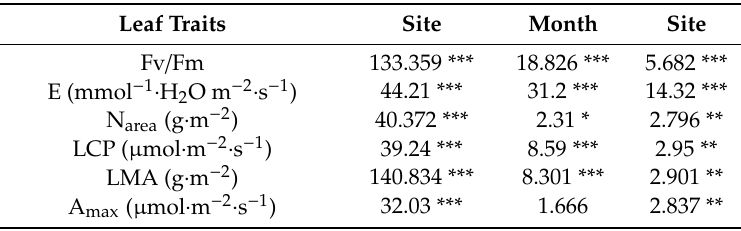
Table 2. The F values of two way-ANOVA for e ff ects of site, month and their interactions on each leaf traits (n = 144) of M. condensatus . Abbreviations are maximum quantum yield of PSII (Fv / Fm); transpiration rate (E); leaf N content (Narea); light compensation point (LCP); leaf mass per area (LMA); light-saturated photosynthetic rate (Amax); water use e ffi ciency (WUE); photosynthetic N use e ffi ciency (PNUE). Significance of the coe ffi cients: * p < 0.05, ** p < 0.01, *** p <